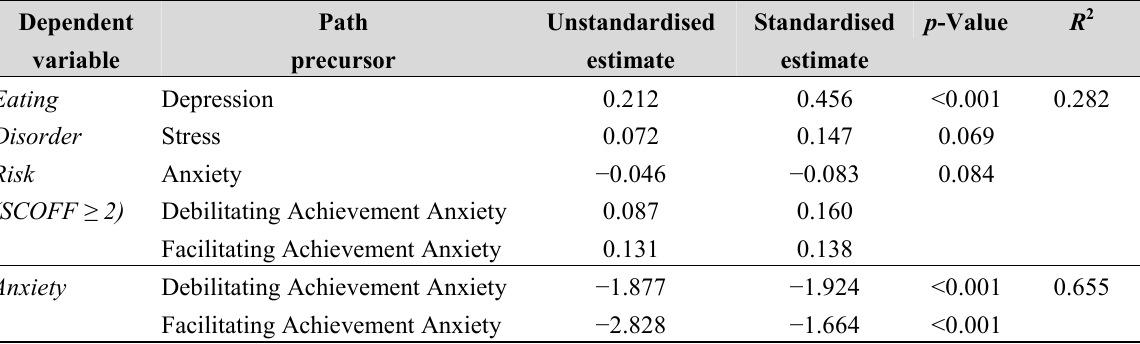
Table 4. Path modelling